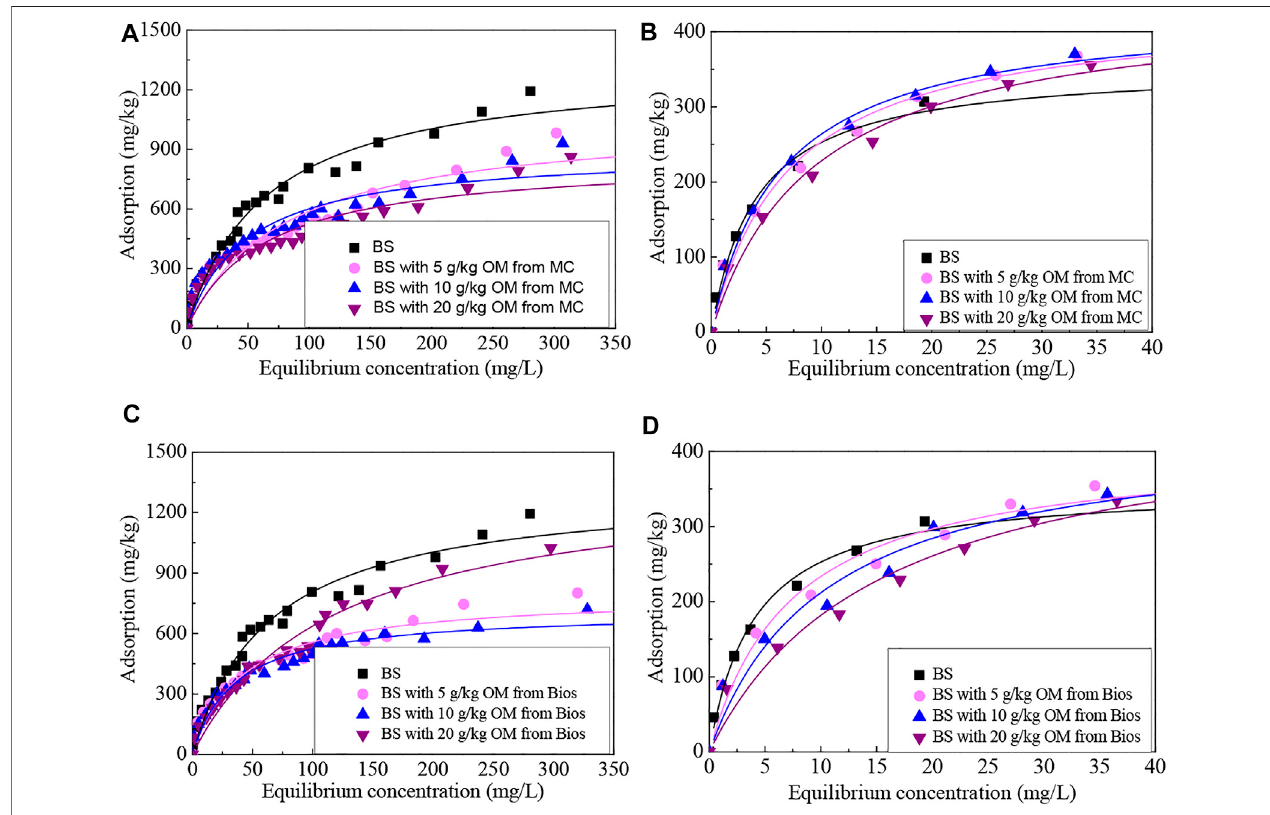
FIGURE 2 | Langmuir isotherms of P adsorbed onto soils incubated with different contents of organic matter derived from (A) (B) manure compost and (C) (D) biosolids.